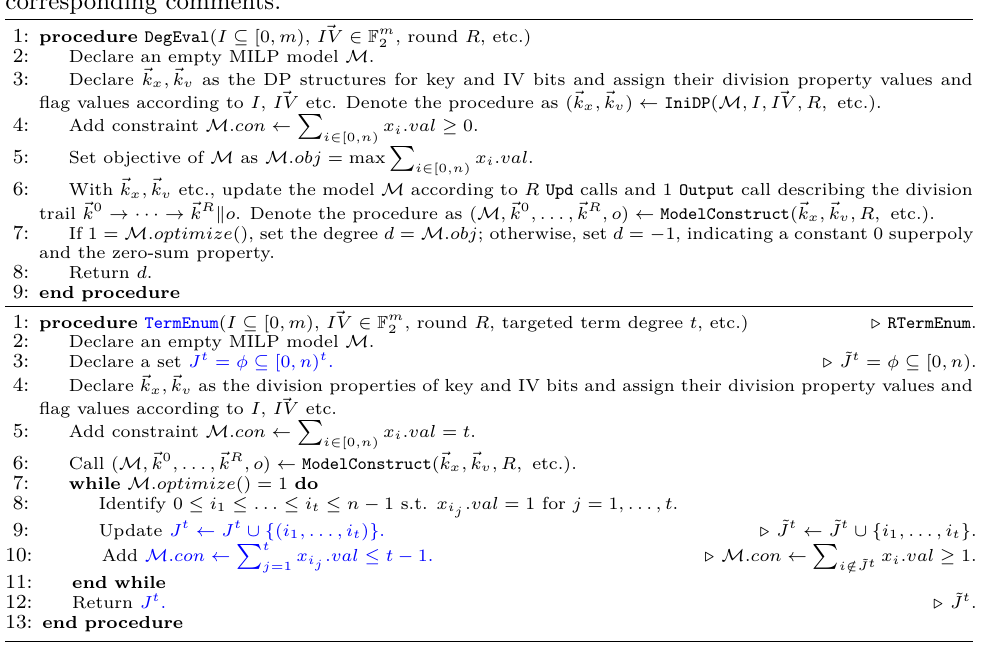
Algorithm 1 The general framework for DegEval , TermEnum and RTermEnum in [WHT + 17] where RTermEnum can be acquired from TermEnum by replacing the blue parts with the corresponding